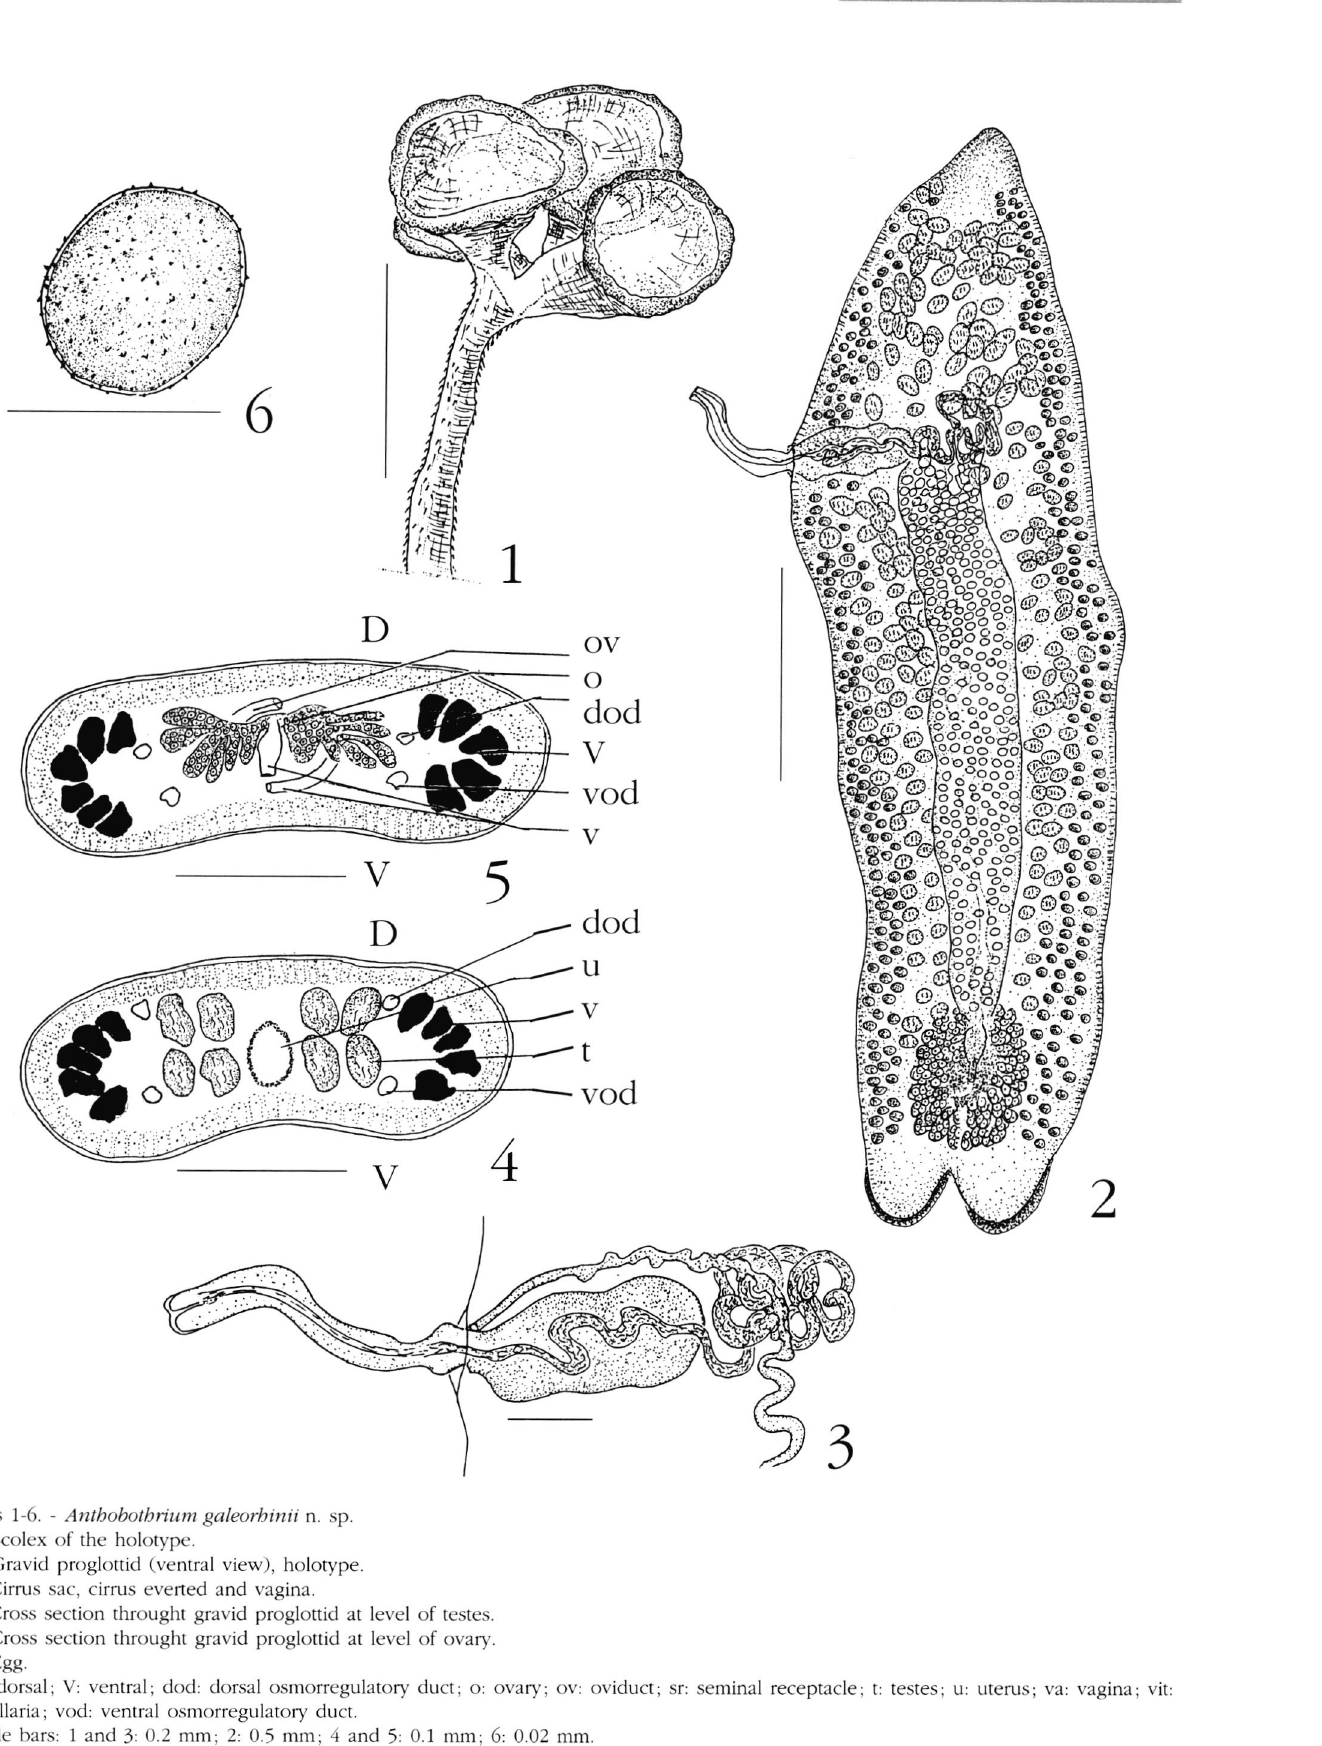
Figs 1-6. - Anthobothrium galeorhinii n. sp. 1. Scolex of the holotype. 2. Gravid proglottid (ventral view), holotype. 3. Cirrus sac, cirrus everted and vagina. 4. Cross section throught gravid proglottid at level of testes. 5. Cross section throught gravid proglottid at level of ovary. 6. Egg. D: dorsal; V: ventral; dod : dorsal osmorregulatory duct; o: ovary; ov: oviduct; sr: seminal receptacle; t : testes ; u : uterus; va : vagina; vit: vitellaria ; vod: ventral osmorregulatory duct. Scale bars: 1 and 3: 0.2 mm; 2: 0.5 mm; 4 and 5: 0.1 mm; 6: 0.02